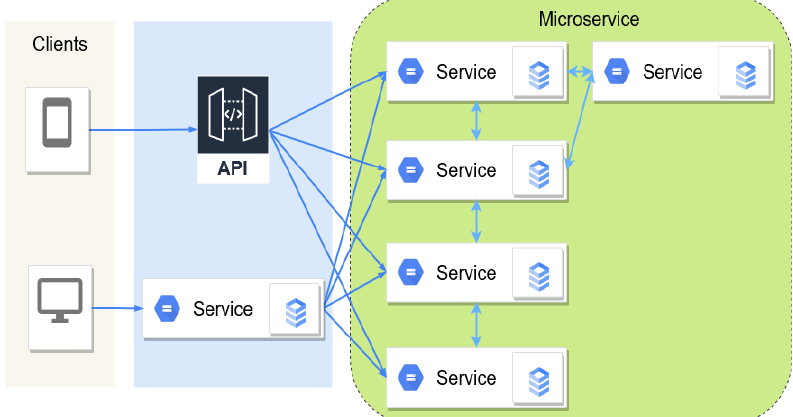
Figure 1. A typical microservice